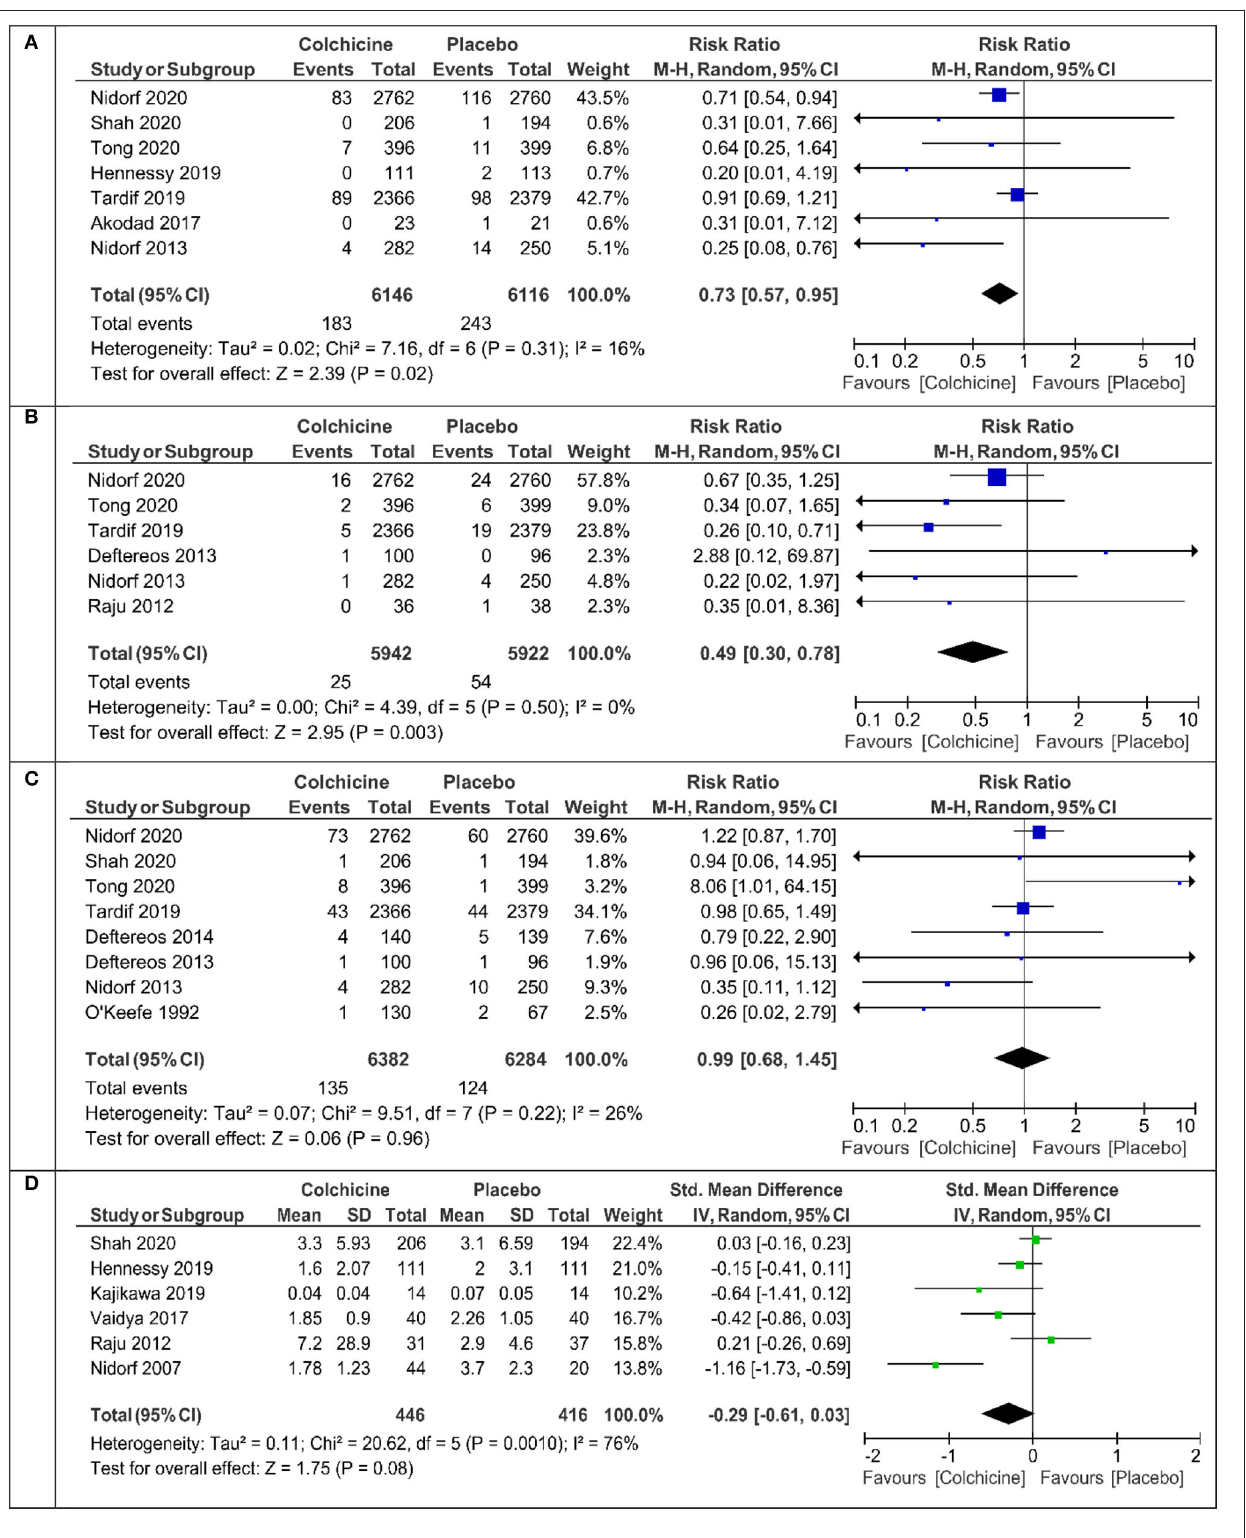
FIGURE 3 | Meta-analysis results for myocardial infarction, stroke, all-cause death, and high-sensitive C-reactive protein (hs-CRP). (A) Myocardial infarction, (B) stroke, (C) death, (D) hs-CRP.